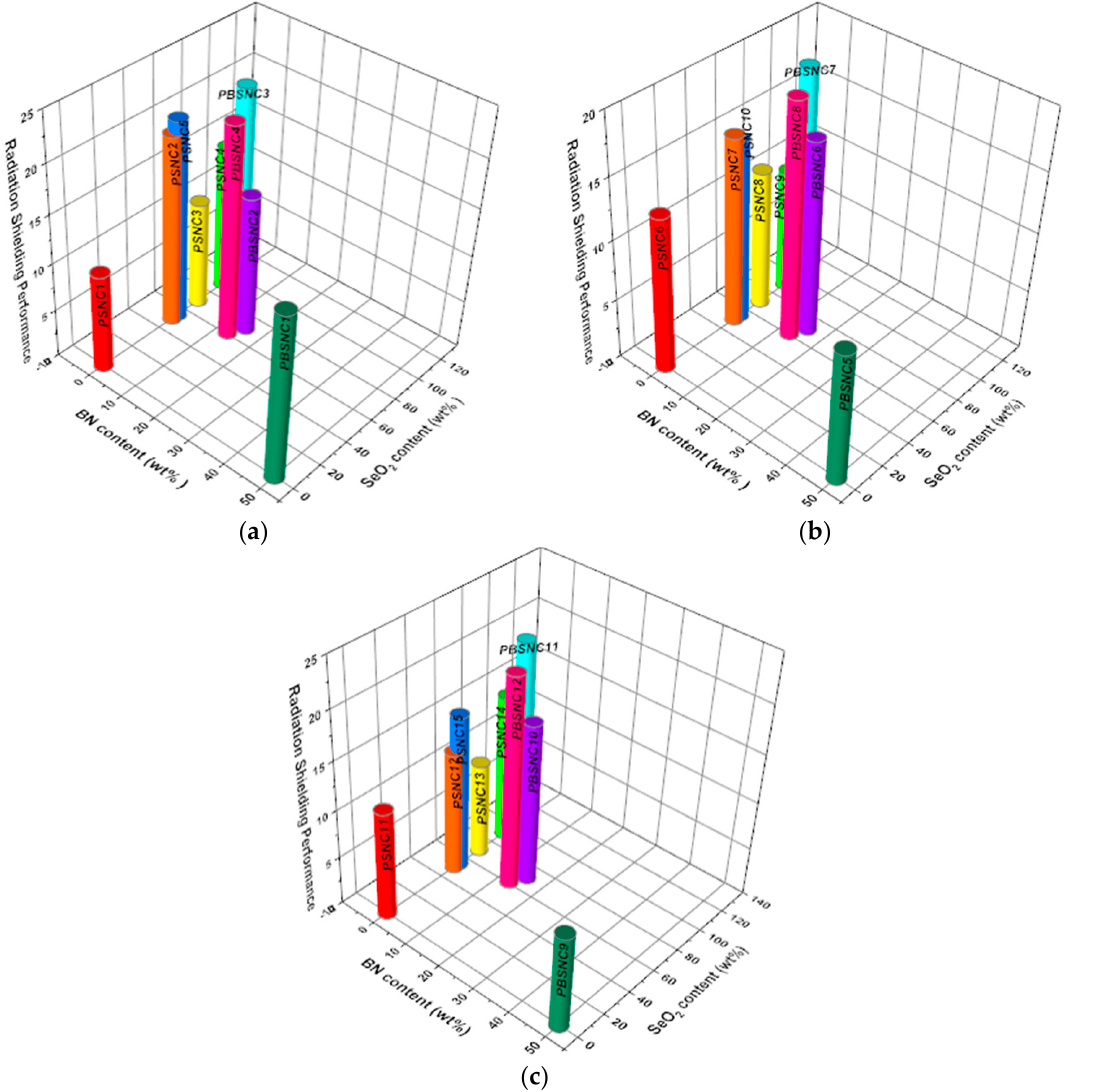
Figure 13. The radiation shielding performance of the PS-b-PEG copolymers blended with the nanostructured SeO 2 and BN particles under a wide range of gamma irradiation energies: PS-PEG (1000) ( a ), PS-PEG (1500) ( b ), and PS-PEG (10,000) ( c ) copolymer and nanocomposite groups.